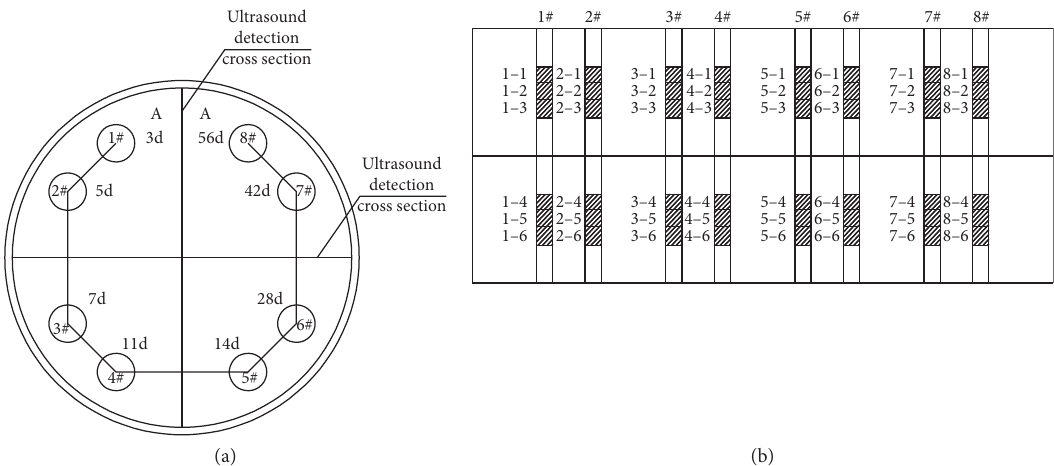
Figure 5: Core sampling positions. (a) Core arrangement for different age strength sampling. (b) A-A section.